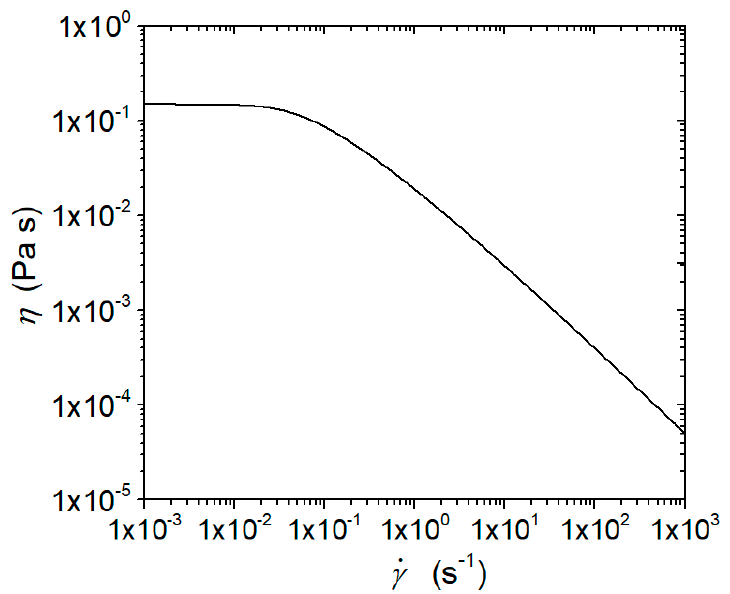
Figure 2. Prandtl–Eyring fluid rheology: apparent viscosity–shear rate relationship. Rheologic parameters from [7]: A = 0.00452 Pa and B = 0.0301 s − 1 .